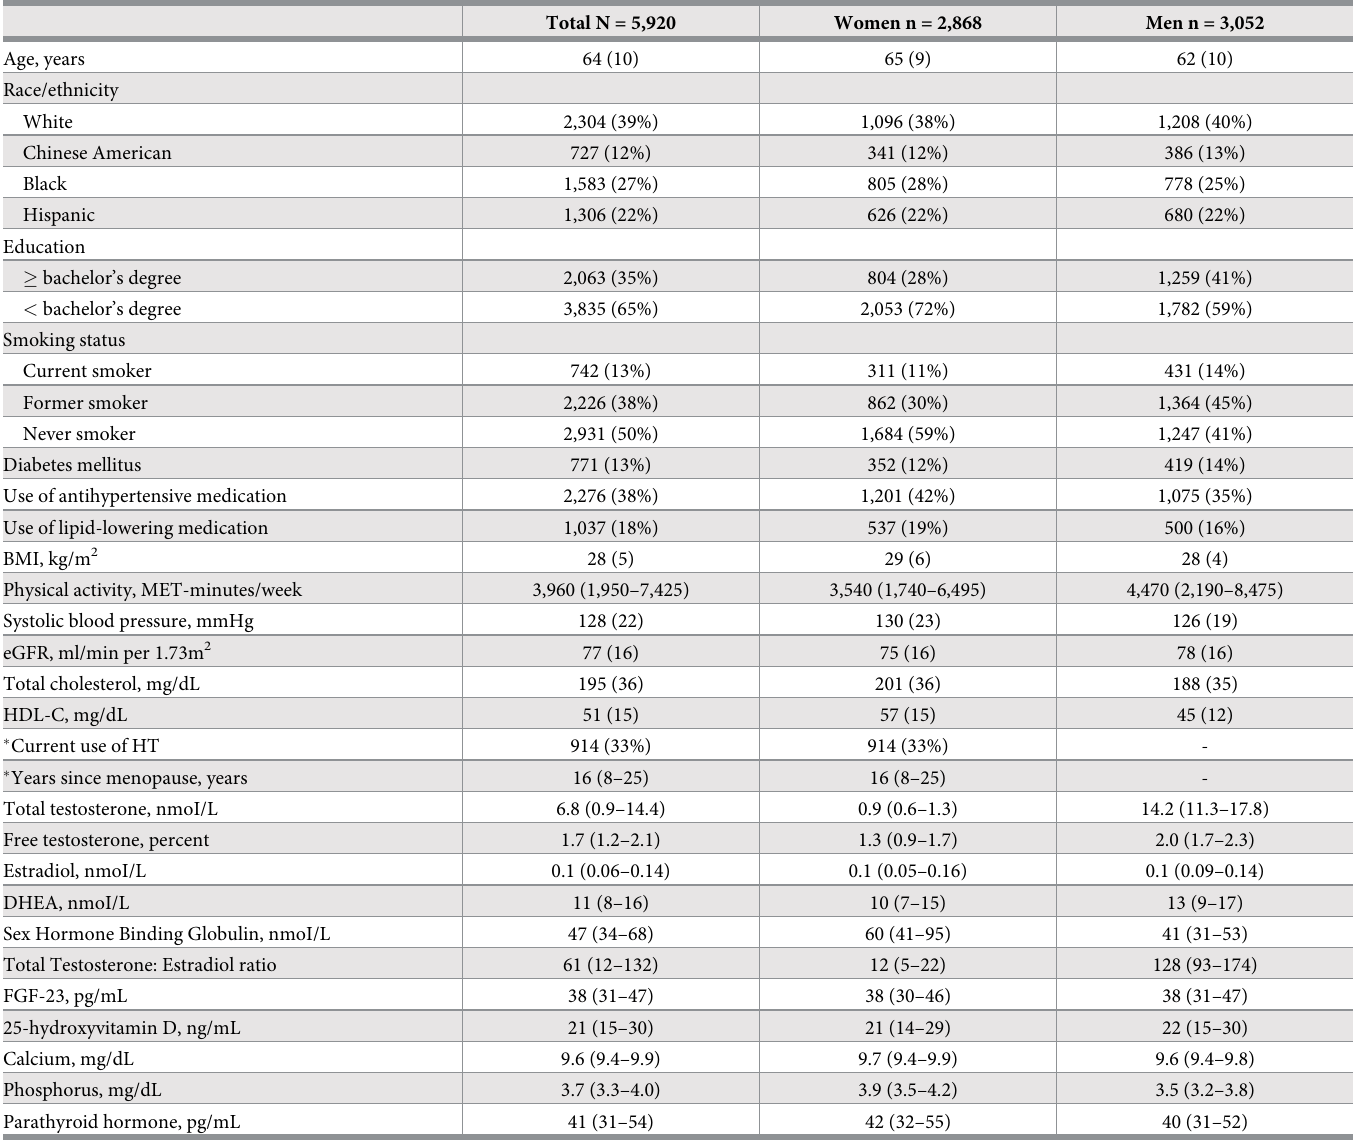
Table 1. Baseline characteristics of study participants, MESA